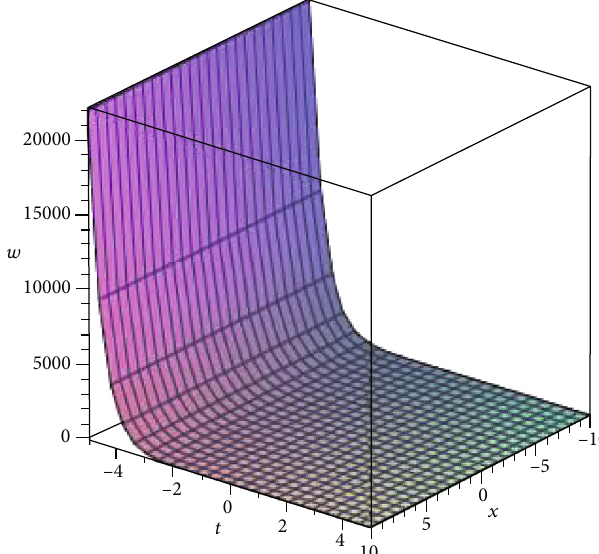
Figure 5: Exact sol. of (1) given in (76).